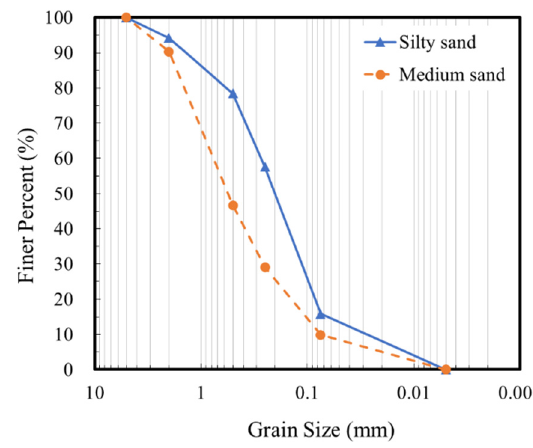
Figure 1. Gradation curve of the silty sand and medium sand.